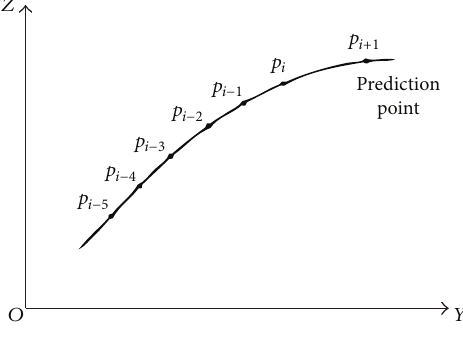
Figure 4: Adaptive measurement principle.